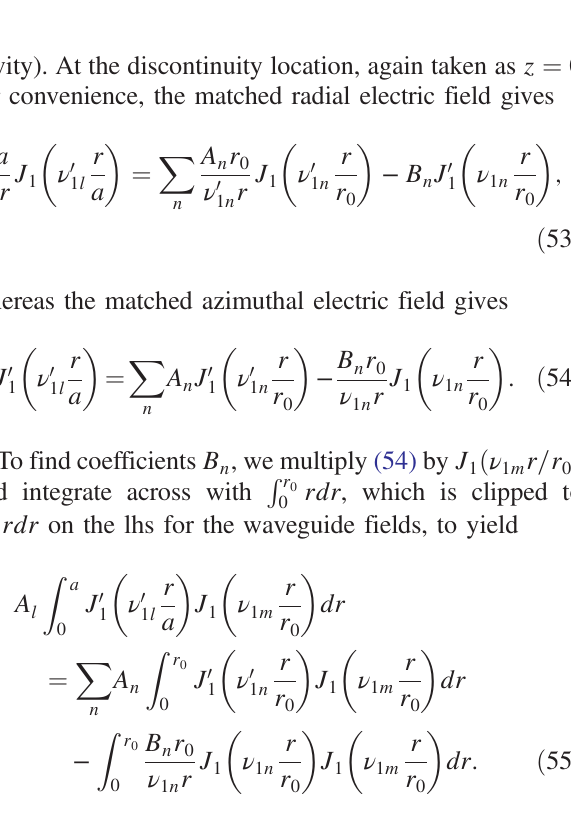
FIG. 5. Comparison of the rhs (green color line) with the lhs (dashed black line) of Eq. (43) for E upper limit of the sums truncated at 300 terms and the ð A values substituted from the results in (48) and (52). In this plot, we took r 0 =a ¼ 2 as an